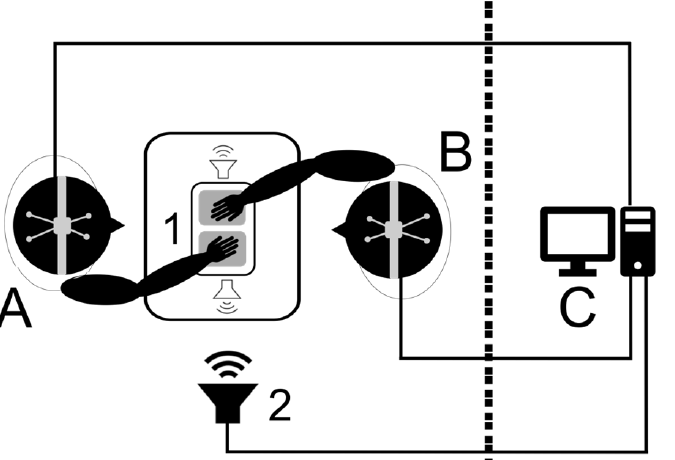
Figure 1. An illustration of the experimental setup during the tapping game. Participants wearing EEG caps ( A , B ) faced each other during the tapping game, tapping on a synth drum pad (1), and turned 90 degrees to their left during pre/post silent periods. Guide tones were played through a speaker (2) from a computer ( C ) in an adjacent room, which was also used for data collection. Each participant wore a low density, 4000 Hz sampling rate dry electrode headset made by Cognionics [82]. The design used for the present study featured 5 electrode place- ments: Fp1, Fp2, Cz, O1, and O2 with a forehead ground and left mastoid reference. As these headsets are not adjustable, the locations of all sites are approximate: head circum- ference and height will affect specific locations on each participant. Although all partici- pant head circumferences fell within the manufacturer specified range of 52 – 62 cm, a cus- tom, specially-made smaller version of the headset was used for participants with smaller heads, to align at the vertex. Two types of electrodes were used: smooth and tined. The smooth electrodes feature a soft, pliable plastic skin and are made for sitting against the bare skin of the forehead. The tined electrodes feature flexible plastic tines arranged in a star-like configuration that comb through hair to reach the scalp (Figure 2). These dry electrodes do not need any gel or any skin preparation other than swabbing bare skin with alcohol swabs. These headsets also feature two analog inputs that are recorded in sync with an EEG. These analog channels allow synchronization of EEG data with external stimuli and thus enable synchronization of recordings between headsets. For the present study, square pulses were sent from the experimental computer to both headsets. Align- ing these square pulse “triggers” in the data allowed data from different headsets to be synchronized to within one sample (0.25 ms).